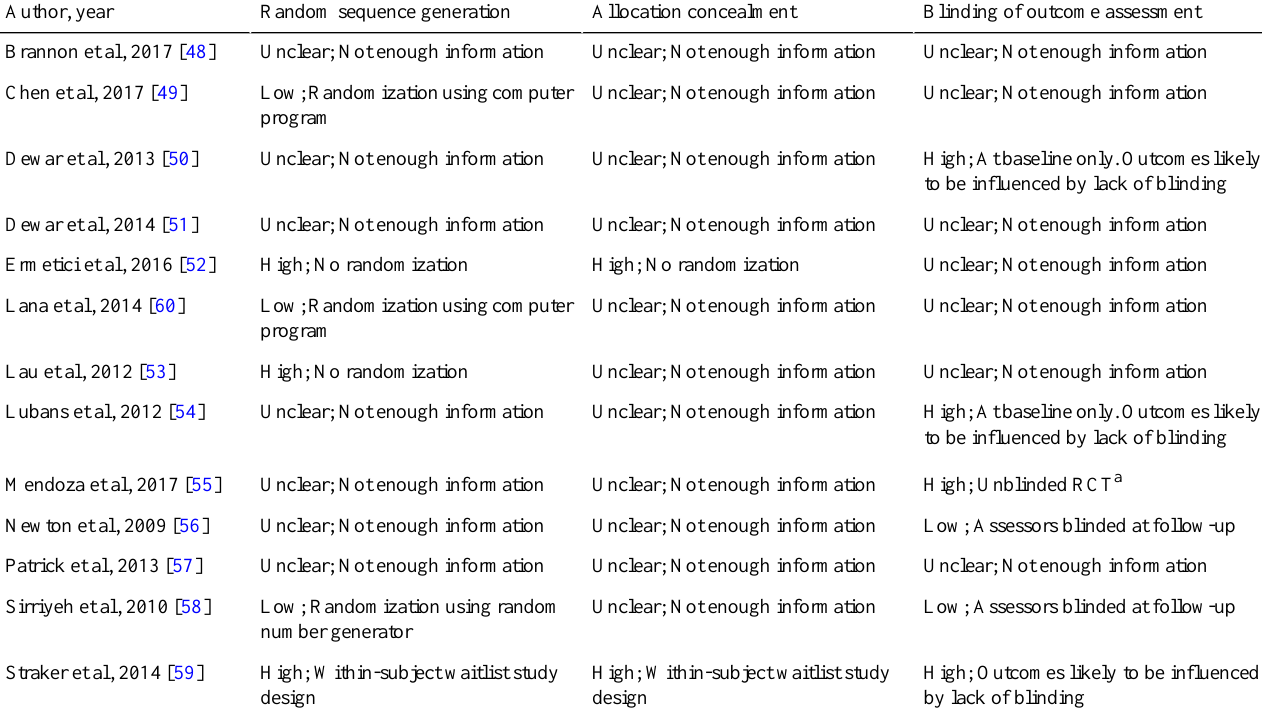
Table 4. Support for judgment of risk of bias per item and study. Random sequence generation, allocation concealment, and blinding of outcome